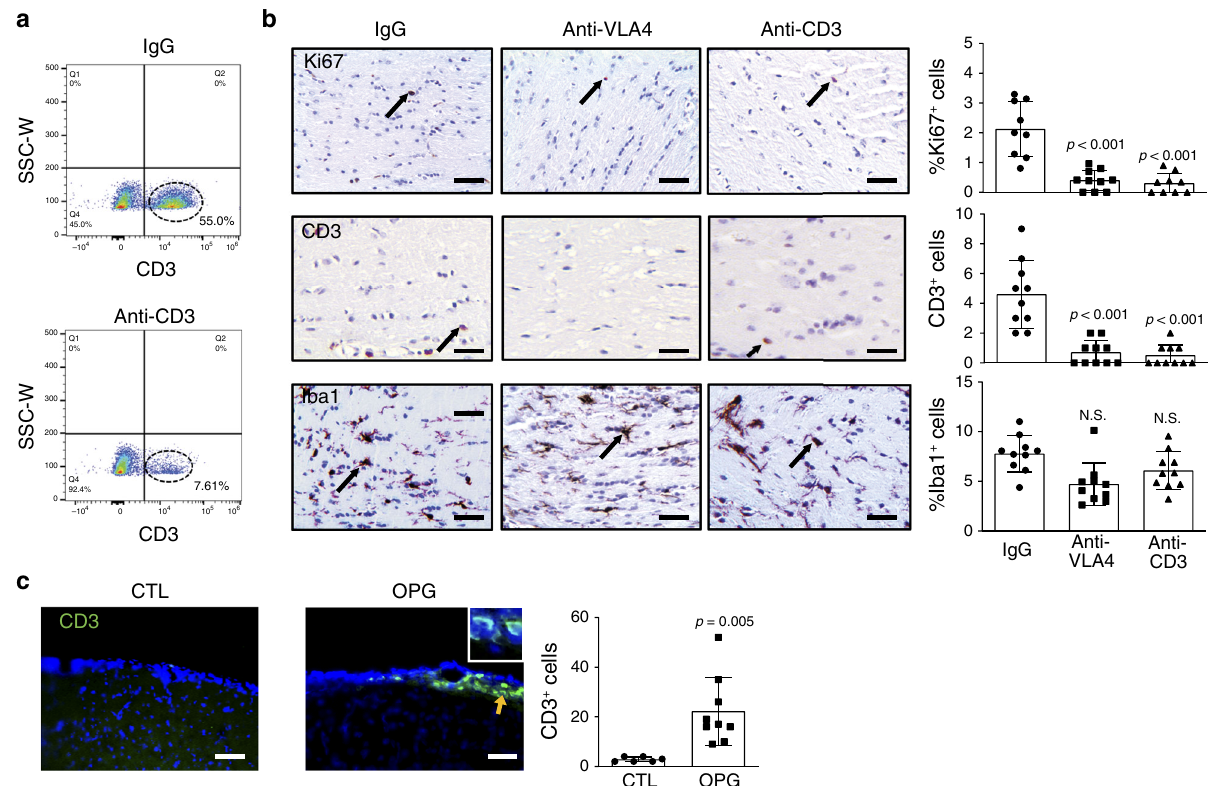
Fig. 4 Nf1 optic glioma mice exhibit increased meningeal and parenchymal T cells. a CD3 + T cells (circled with dash line) were depleted in splenocytes from anti-CD3 antibody-treated mice (7.6%) relative to IgG-treated mice (55%), as measured by fl ow cytometry. b Immunohistochemistry revealed that anti-VLA4 and anti-CD3, but not control IgG, antibody treatments reduced CD3 + T cell in fi ltration and the percentage of Ki67 + cells in murine Nf1 optic gliomas. No differences in microglia content (%Iba1 + cells) were observed in the anti-VLA4 and anti-CD3 groups compared to the IgG controls. Arrows denote representative immunopositive cells. Black arrows indicate representative immunopositive cells. c Immuno fl uorescence microscopy revealed increased meningeal CD3 + lymphocyte in fi ltration in optic glioma (OPG)-bearing mice, relative to the control (CTL) mice. Yellow arrow denotes representative immunopositive cells. DAPI (blue) is used as a nuclear counter stain. a , c Scale bars, 40 µ m. b Bar graphs represent the means ± SEM of (top panel) IgG, n = 9; anti-VLA4, n = 10; anti-CD3, n = 9; (middle and bottom panels), all groups had n = 10 independent biological samples. c Bar graphs represent the means ± SEM of CTL, n = 6; OPG, n = 9; independent biological samples. b One-way ANOVA with Bonferroni post-test correction; c Two- tailed Student ’ s t -test. Exact P values are indicated within each panel; N.S.; not signi fi cant. From left to right in each panel: b top panel: all P < 0.001, middle panel: all P < 0.001, bottom panel: all N.S.; c P = microglial Ccl5 production in response to activated T cell CM